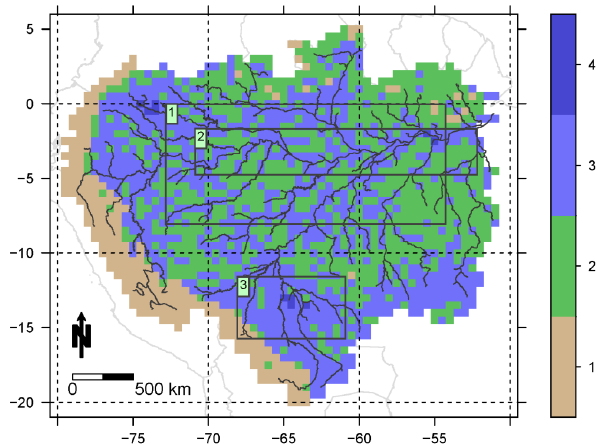
836 Fig. 5. Fraction classes of floodable area per cell. Class 1 repre- senting < 5%, class 2 representing ≥ 5–10%, class 3 representing Figure 5. Fraction classes of floodable area per cell. Class 1 representing <5%, class 2 837 ≥ 10–15%, class 4 representing ≥ 15–45% of floodable area. For a representing ≥5-10%, class 3 representing ≥10-15%, class 4 representing ≥15-45% of 838 comparison of simulated floodable area with floodplain area (rect- angles R1–R3) see Table floodable area. For a comparison of simulated floodable area with floodplain area 839 (rectangles R1–R3) see Table 6. 840 841